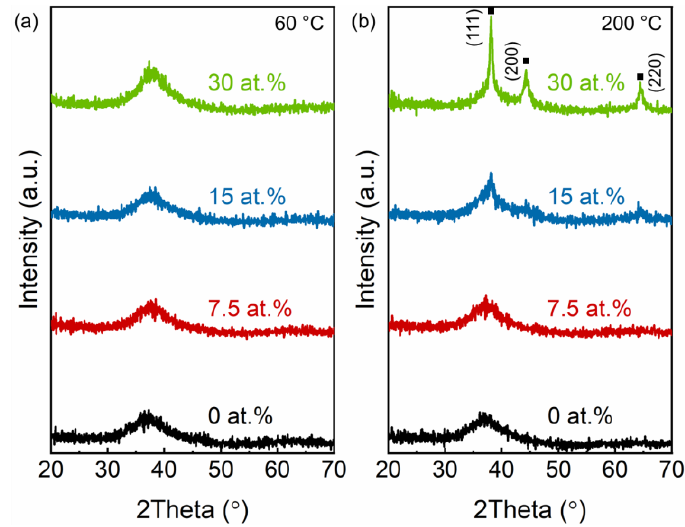
Figure 3. X-ray diffractograms (XRD) of TFMG and Ag-containing TFMGs deposited without substrate bias potential at ( a ) 60 and ( b ) 200 °C.